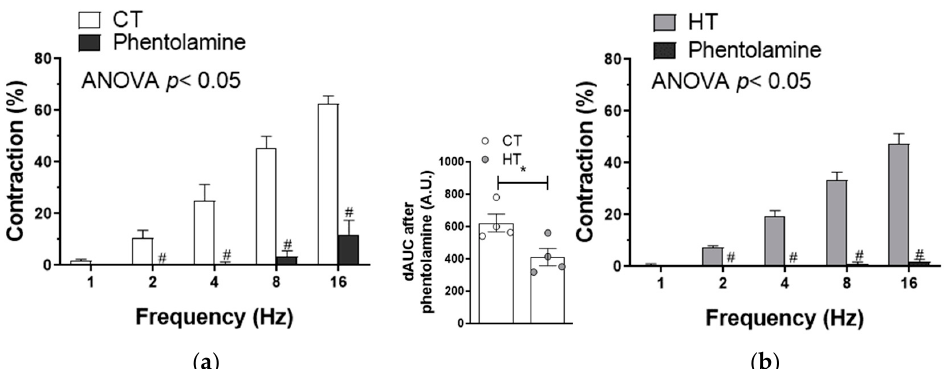
Figure 2. Effect of alpha-adrenergic antagonist phentolamine (1 µmol/L) on EFS-induced vasoconstriction in mesenteric segments from control (CT; ( a )) and rats with hyperthyroidism (HT, ( b )). Results (mean ± S.E.M.) are expressed as a percentage of previous tone induced by KCl. # p < 0.05 conditions without drug vs. phentolamine at each frequency (Bonferroni post hoc test). n = 4 segments from different rats in each experimental group. Insert graph shows differences in the area under the curve (dAUC) in presence/absence of phentolamine. * p < 0.05 CT vs. HT (Student’s t -test).